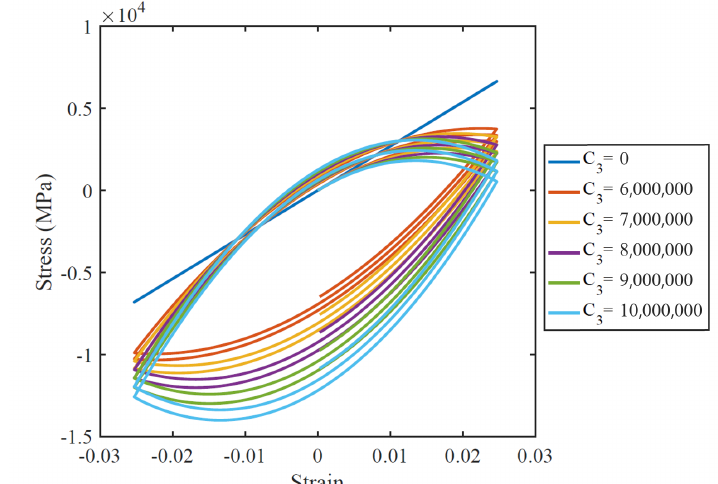
Figure 12. Stress-strain curves for different